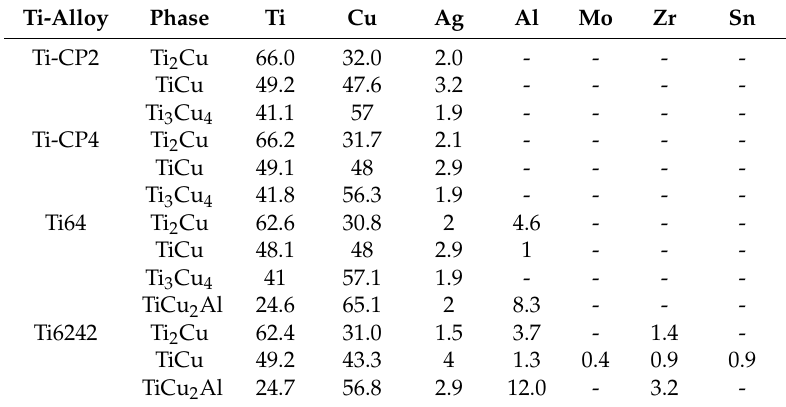
Table 2. Results of EDS analysis of intermetallic phases in the transition zone (Figure 1) (at. %). Ti-Alloy Phase Ti Cu